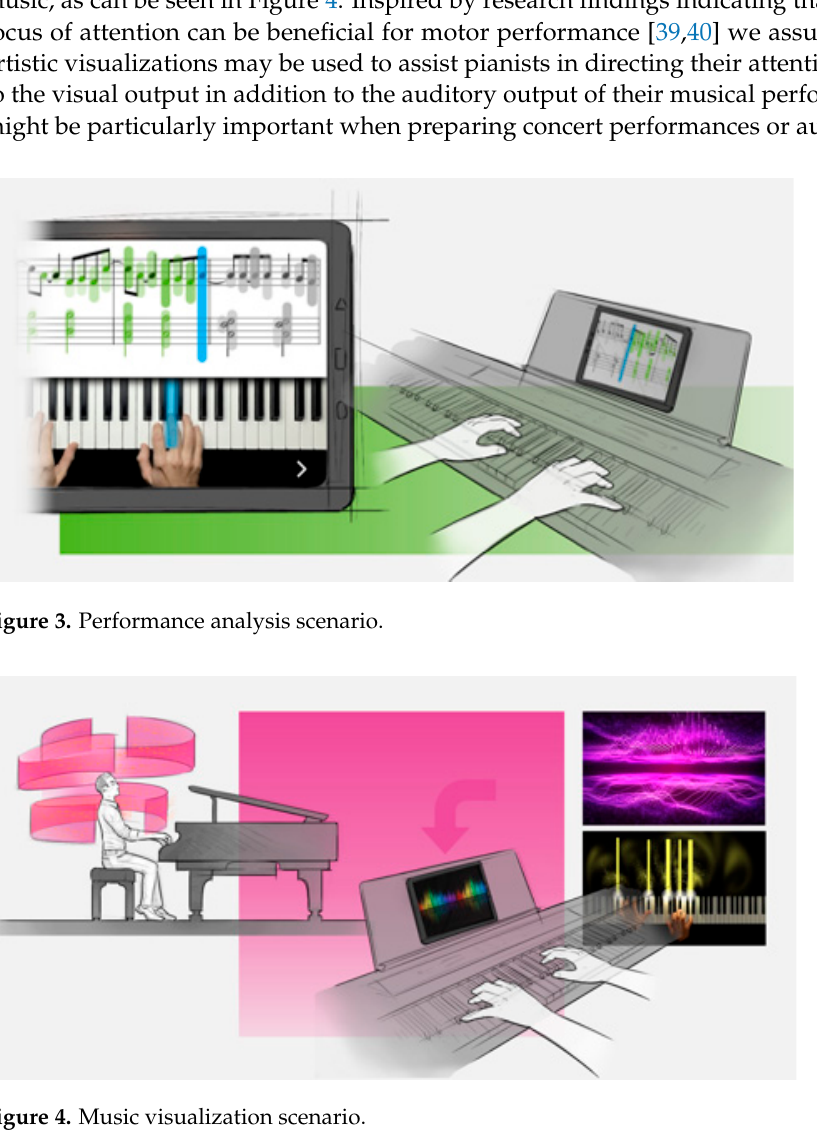
Figure 4. Music visualization scenario.